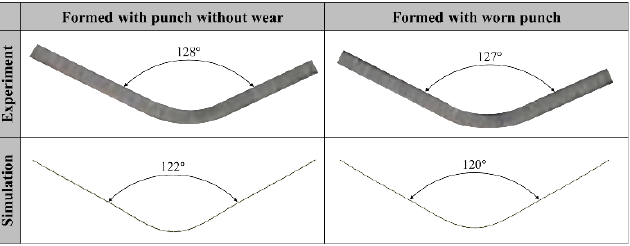
Figure 20. Comparison of experiment and simulation results for the cross-section of the product formed with punch geometry without wear and worn punch geometry.